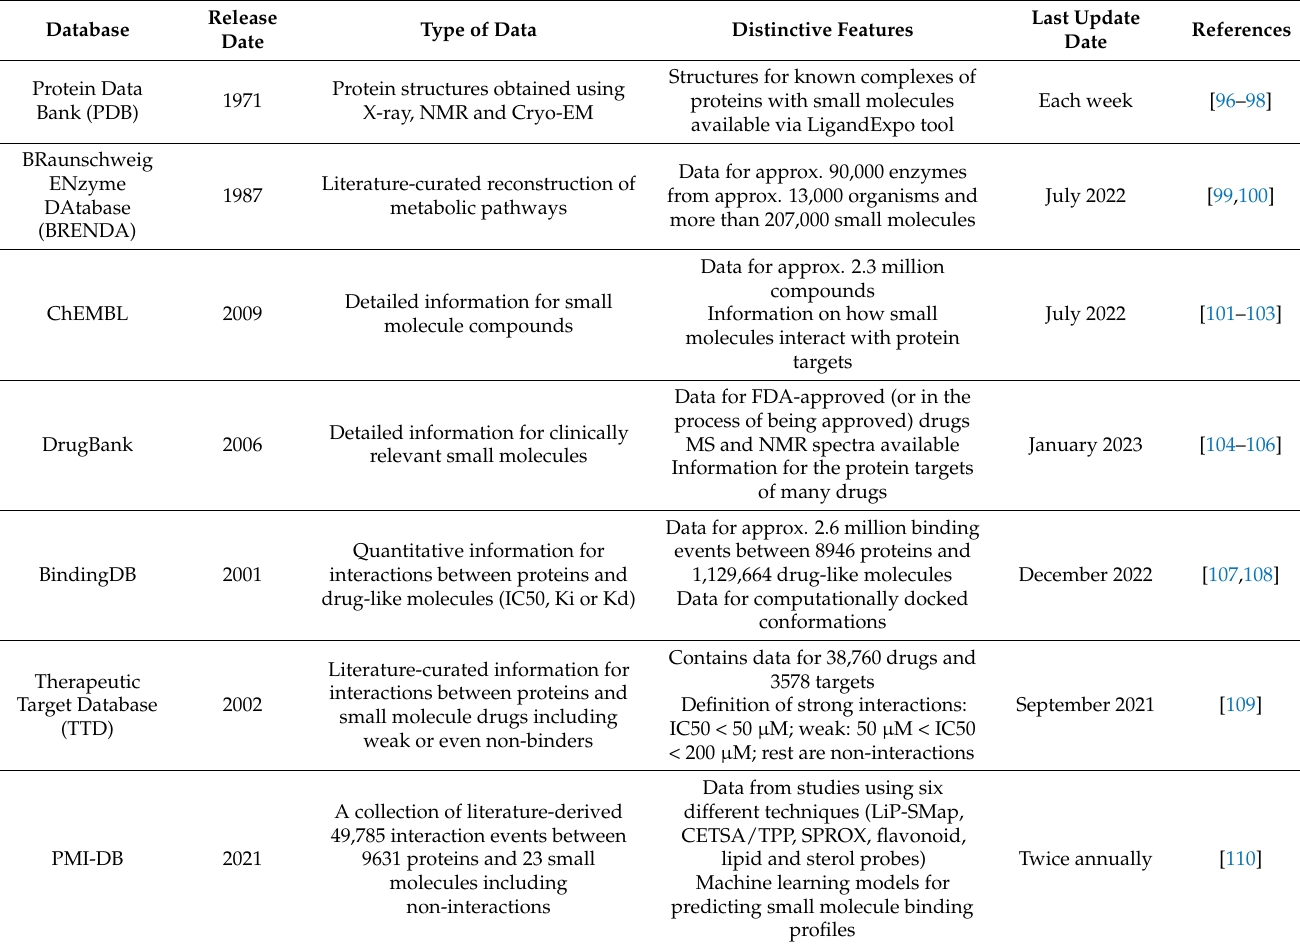
Table 2. Databases with information on